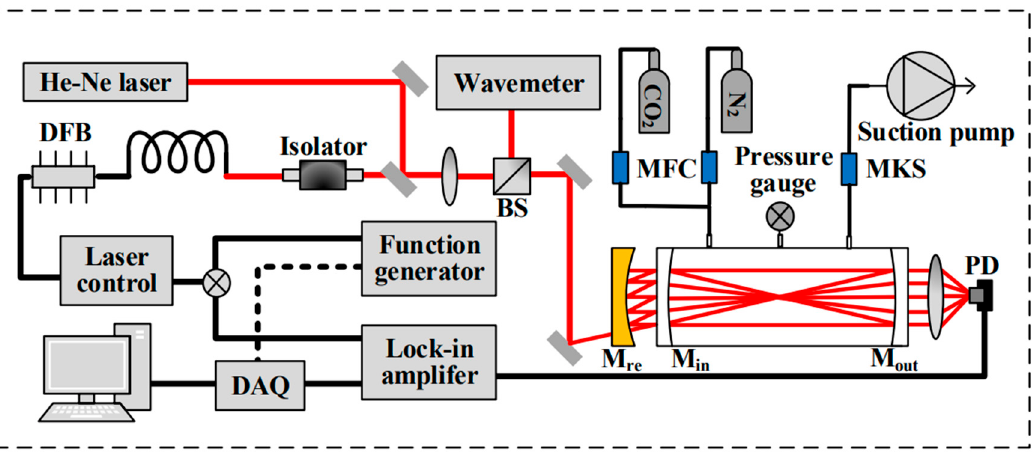
Figure 1. Experimental setup of WM-RE-OA-ICOS set-up. DFB: distributed feedback laser; BS: beam splitter; MFC: mass flow controller; PD: photodetector; DAQ: data acquisition card.